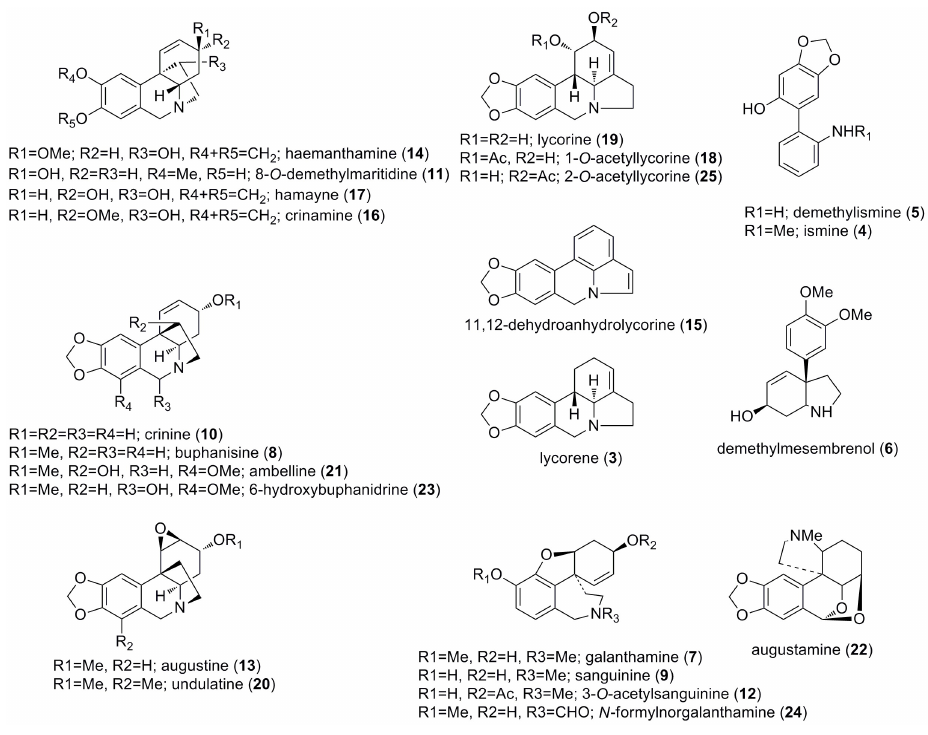
Figure 1. Alkaloids identified in C. amabile by GC-MS.